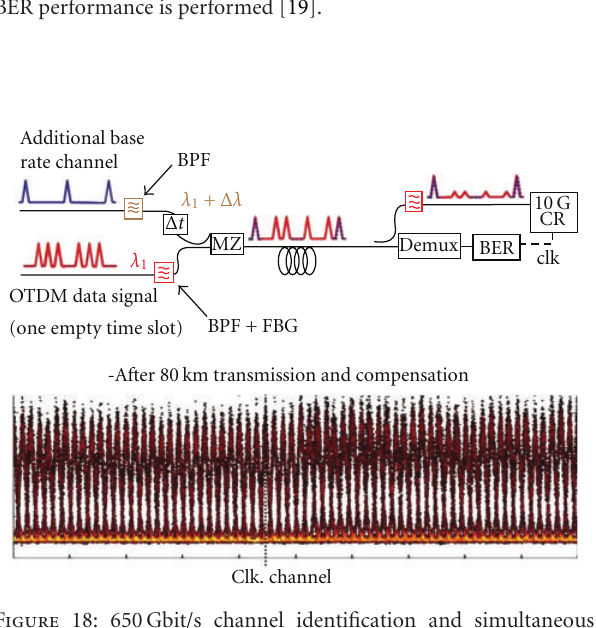
Figure 17: Time-lens-based data packet synchronisation and RZ conversion. A 12.000 bits long NRZ packet o ff set with 200 kHz to the local clock is synchronised, RZ-converted, and multiplexed with a 40 Gbit/s OTDM signal. To prove the principle, demultiplexing with error-free BER performance is performed [19].